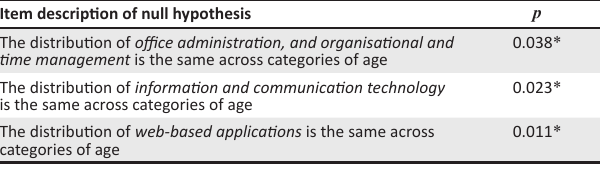
TABLE 1: Relationship between age and